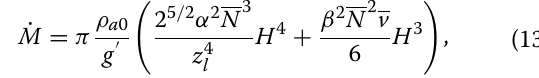
Table 1 Plume heights estimated for each radar, and